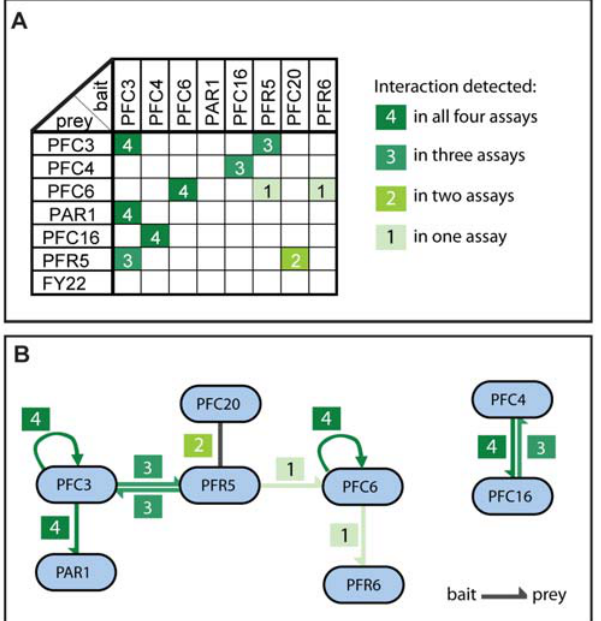
Figure 1. A yeast two-hybrid interaction map for the PFR. A. Summary table of all yeast two-hybrid interactions. For each pair, the number of assays in which an interaction was observed is shown. B. Cartoon representation of the yeast two-hybrid interactions described in A. The number of assays in which an interaction was detected is shown.